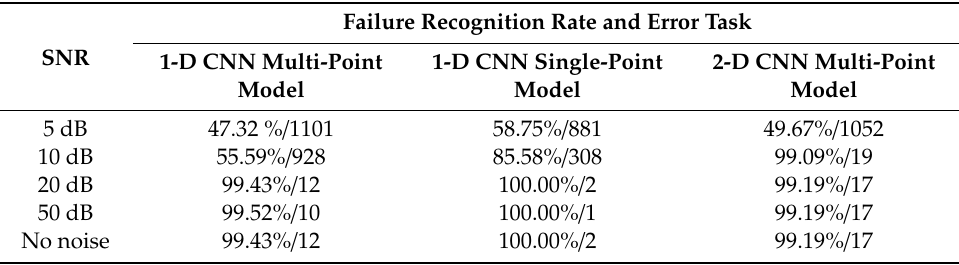
Table 5. Comparison of the diagnostic e ff ects of di ff erent models on the test set.